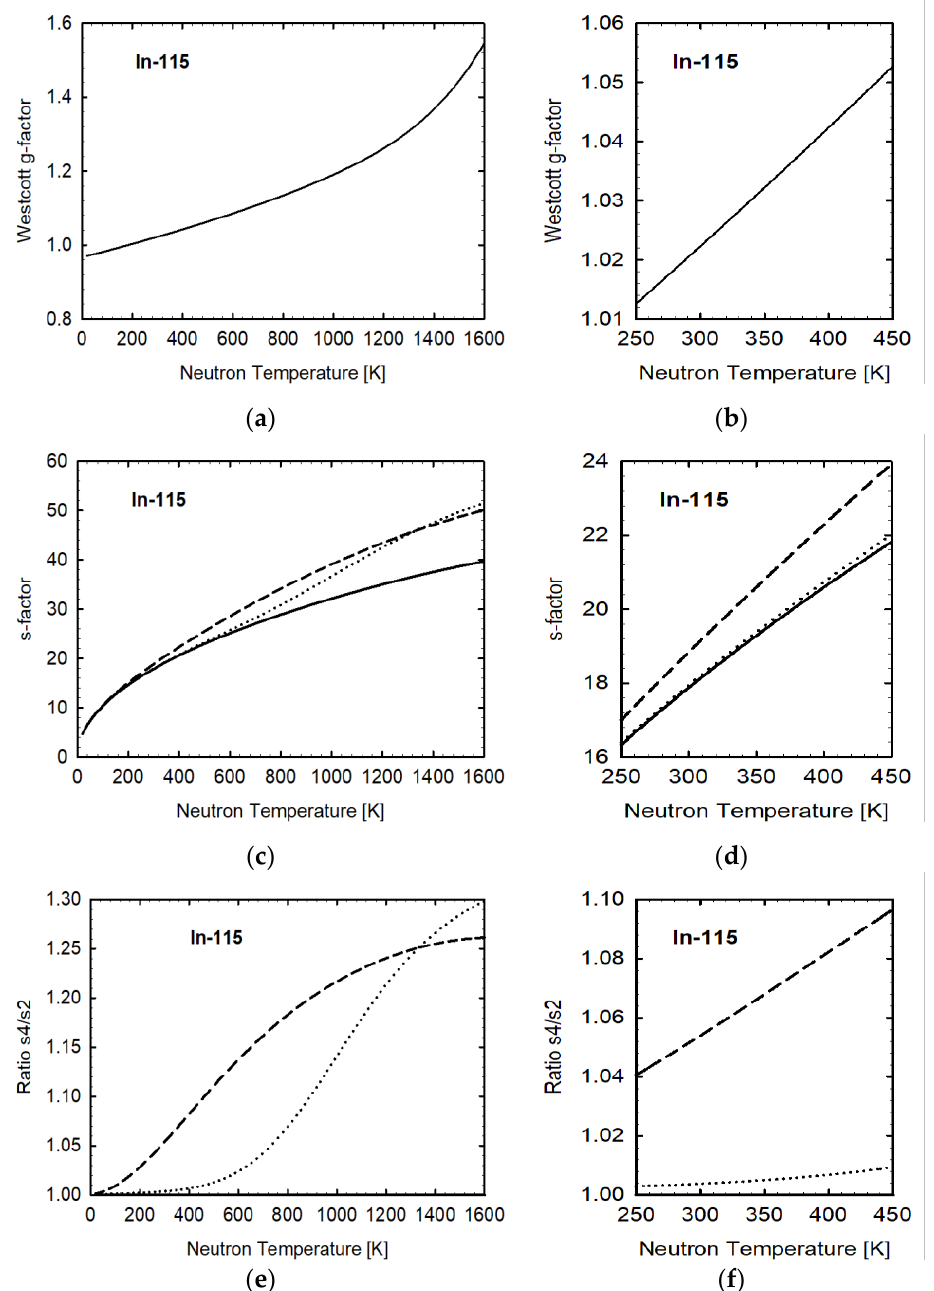
Figure 11. ( a ) Westcott g-factor for 115 In as a function of neutron temperature 𝑇 𝑛 ; ( b ) Expanded figure of ( a ); ( c ) s-factors, s 2𝑊 (solid line), s 4𝑊 (dotted line), s 4𝐻 (dashed line) for 115 In as a function of neutron temperature 𝑇 𝑛 ; ( d ) Expanded figure of ( c ); ( e ) Ratios of s-factors, s 4𝑊 /s 2𝑊 (dotted line) and s 4𝐻 /s 2𝑊 (dashed line) for 115 In; ( f ) Expanded figure of ( e )